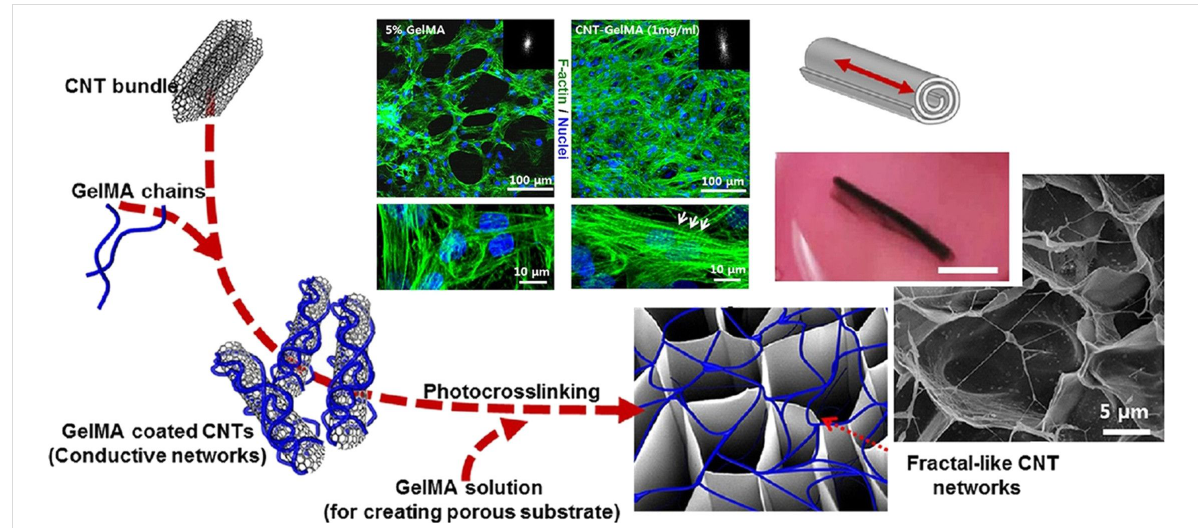
Figure 4: Schematic representation of GelMA-coated CNTs embedded in gelatin hydrogel for the preparation of the engineered cardiac tissue. Confocal images revealed that cardiomyocytes cultured on 1 mg/mL CNT-GelMA hydrogel had a more uniform cell distribution relative to cells cultured on control GelMA hydrogel. Schematic representation of a tubular actuator and its beating direction (red arrow) in addition to an optical image of a sample. Figure 4 was reprinted with permission from [132], Copyright (2013) American Chemical Society. This content is not subject to CC BY